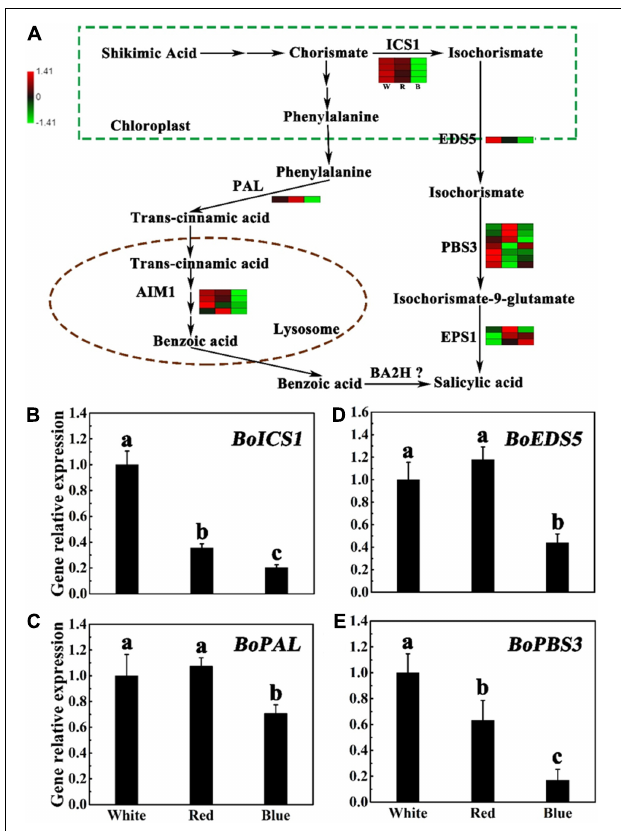
FIGURE 4 | Expression of SA biosynthesis-related genes under different lights. (A) Flow chart of SA biosynthesis. The heat map shows the differences in the expression of genes related to I3C synthesis in broccoli sprouts under different lights. W, R, B, means white, red, and blue light. The values of log 2 [fold change (FC)] was represented using the depth of color, with green representing low expression and red representing high expression. Fold change means the ratio of the gene expression in blue light treatment to it in control. (B–E) Transcript analysis of SA biosynthesis-related genes in broccoli sprouts with different light treatments. Data represented as means ± SD from three independent experiments. Different letters indicated statistical differences ( P <